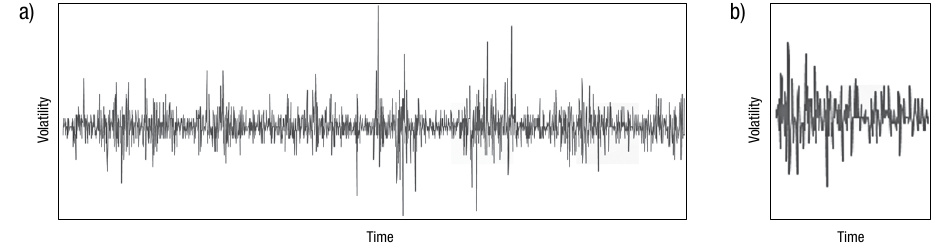
Fig. 9. Example of the sequence of damped oscillations in 5-minutes volatility series of EUR/USD (a), detailed